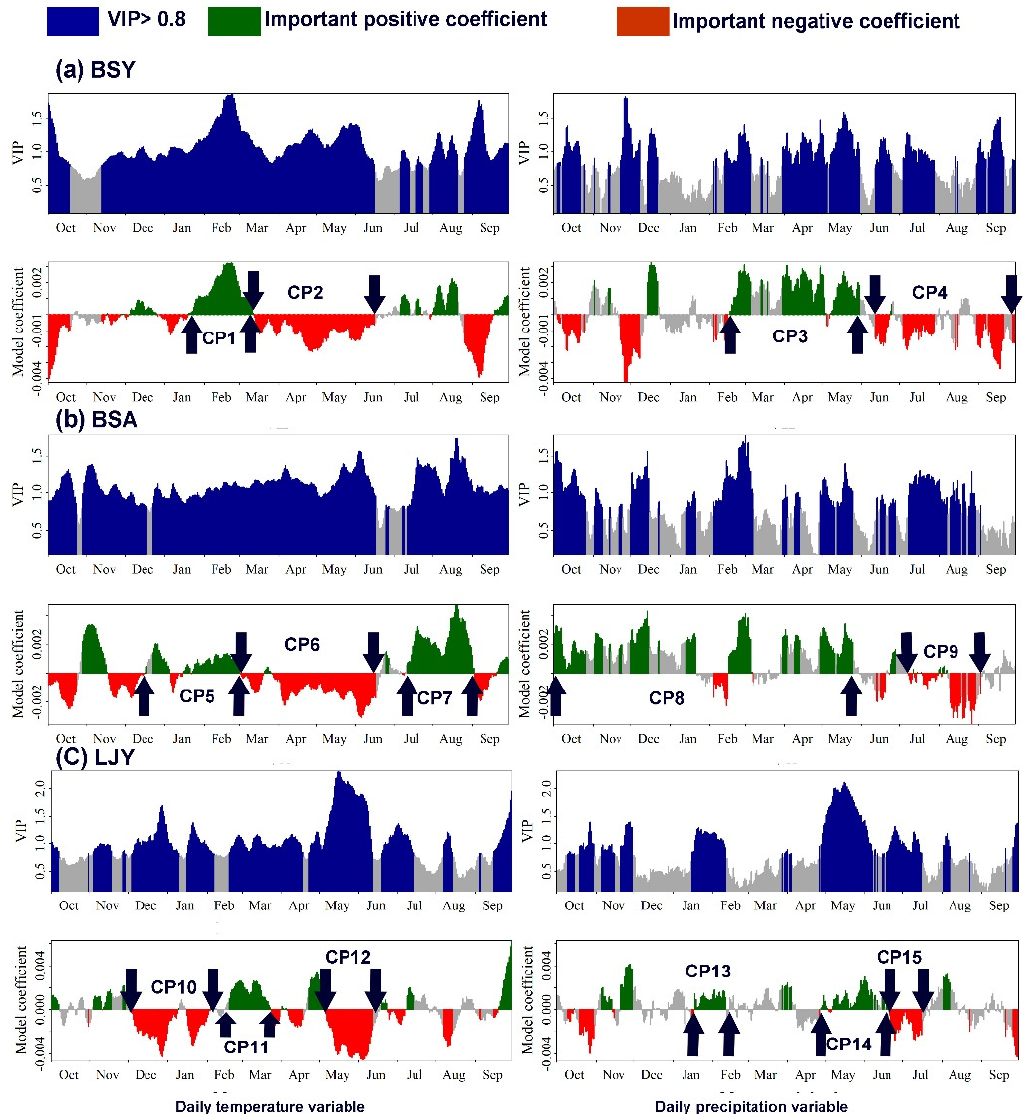
Figure 5. Results of Partial Least Squares (PLS) regression for correlating tree-ring widths of Pinus yunnanensis ( a ) at BSY and Pinus armandii ( b ) at BSA, and P. yunnanensis ( c ) at LJY in Yunnan from